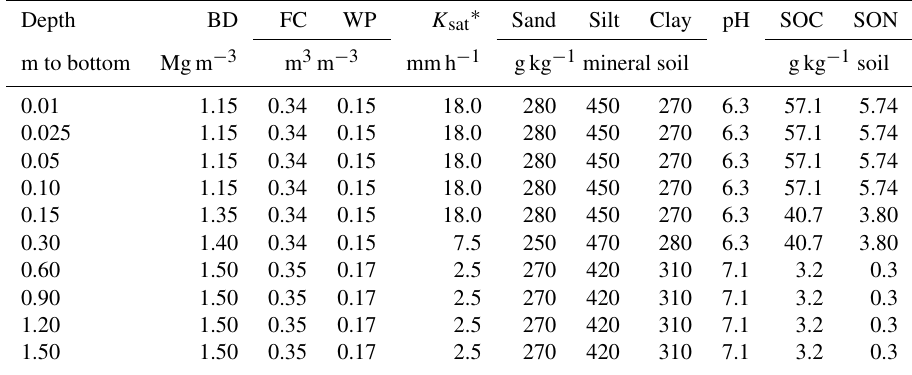
Table 2. Key soil properties of the Black Chernozem soil at the South Campus Farm used in ecosys. SOC is soil organic carbon, and SON is soil organic nitrogen.